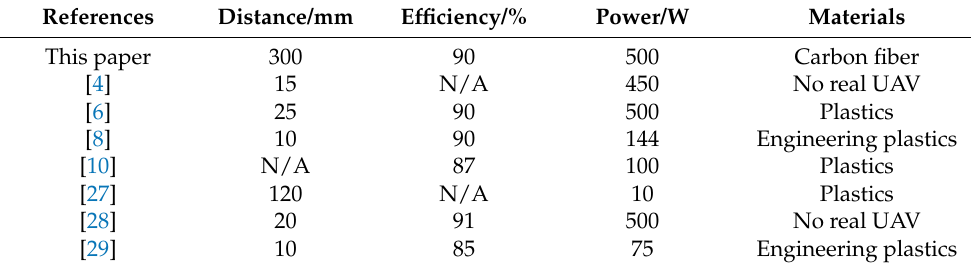
Table 4. Characteristic parameters of the proposed prototype vs. references.